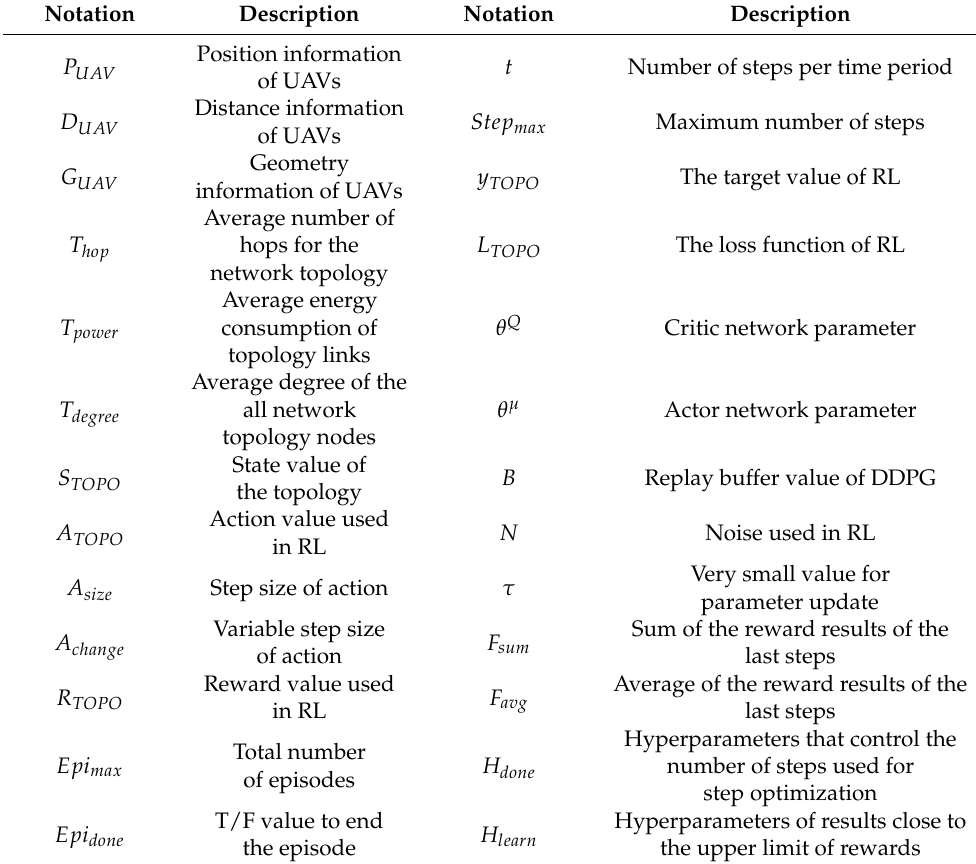
Table 1. Variables used in proposed